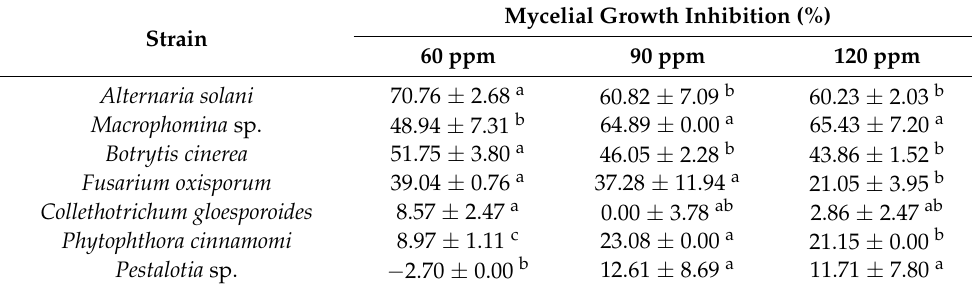
Table 1. Percentage inhibition of radial growth of phytopathogenic fungi strains at different silver nanoparticles concentrations